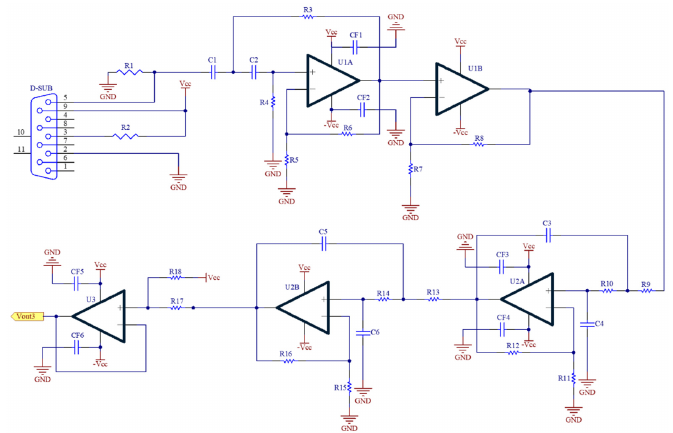
Figure 3. The circuit schematic for PPG